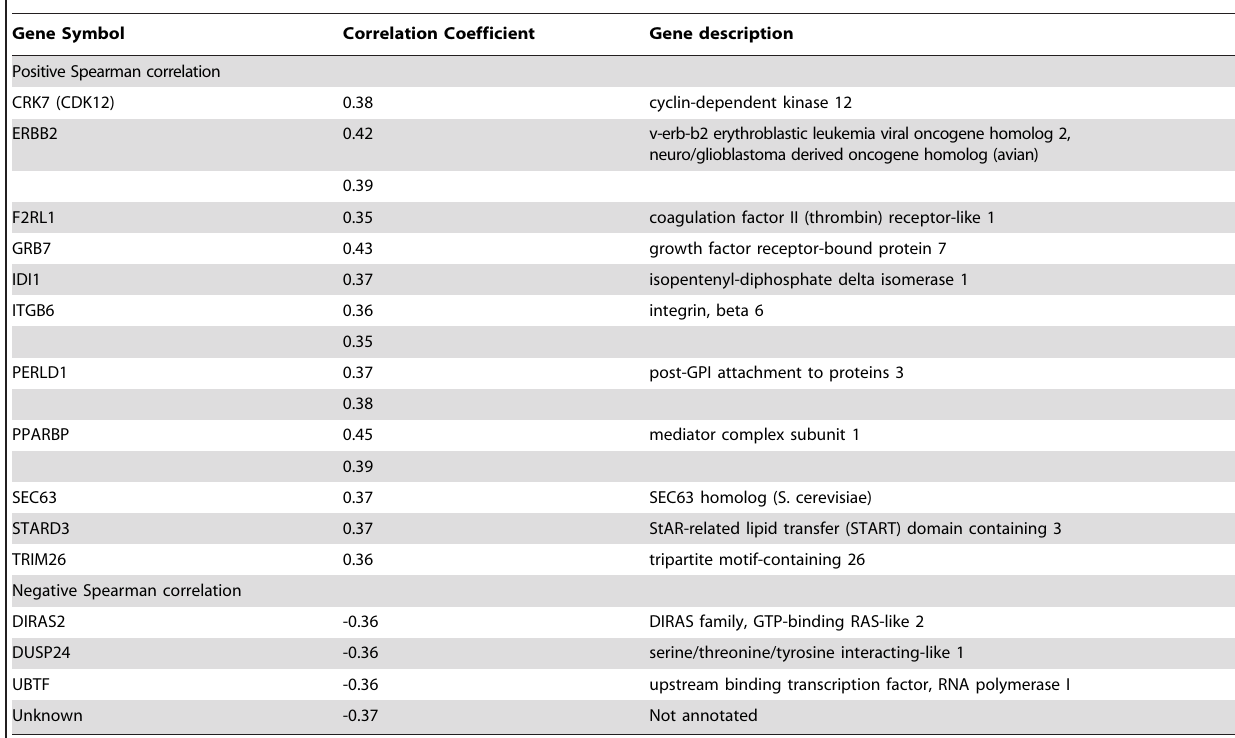
Table 3. Gene signature predictive of ERBB2 status.